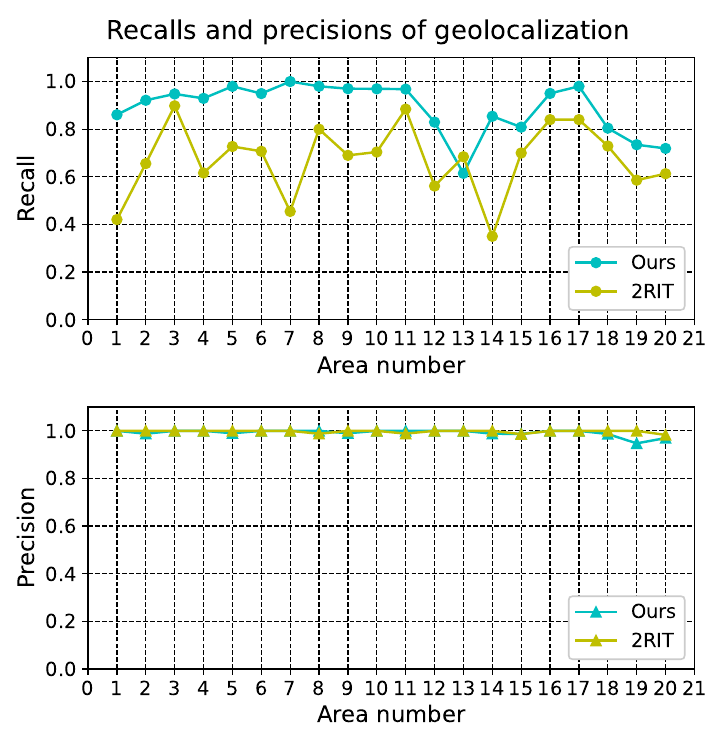
Figure 10. Precision and recall of geolocalization in different areas of the “2RIT” method [5] and our